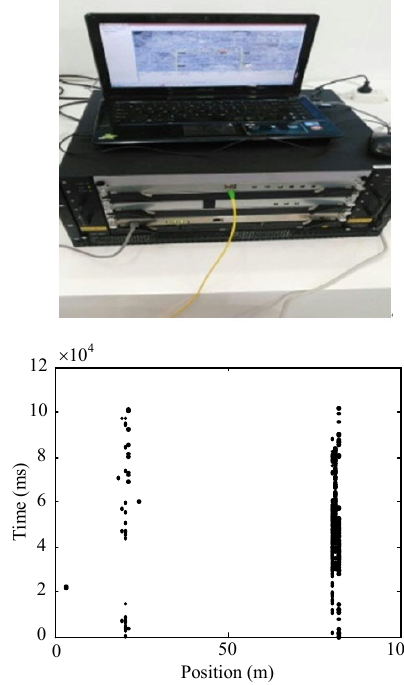
Fig. 4 Detection result of optical vibration